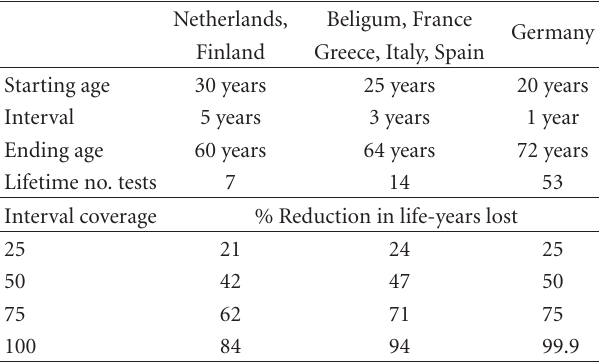
Table 2: † Reduction (%) in life years lost according to policy and